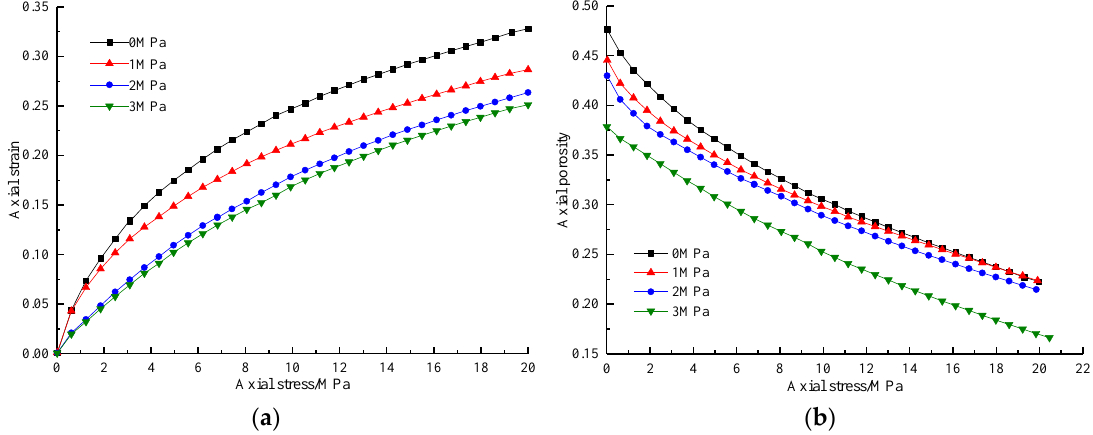
Figure 9. Changes in axial strain and porosity of the samples under axial load. ( a ) Axial strain; ( b ) Axial porosity .